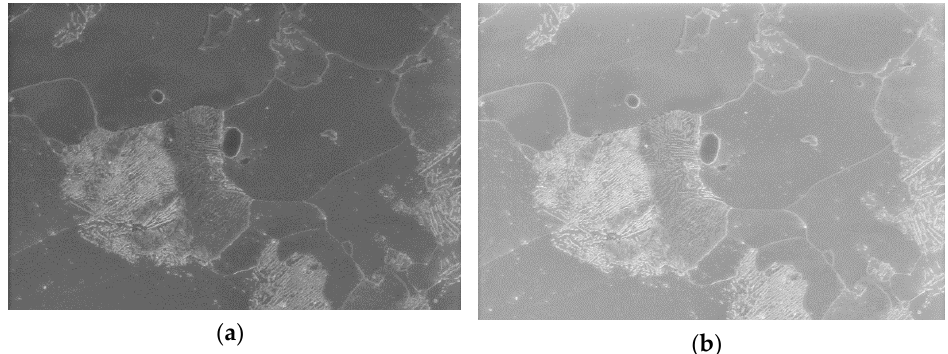
Figure A5. Example of a microstructure surface at different contrasts of SEM: ( a ) contrast = 49%, ( b ) contrast = 52%.